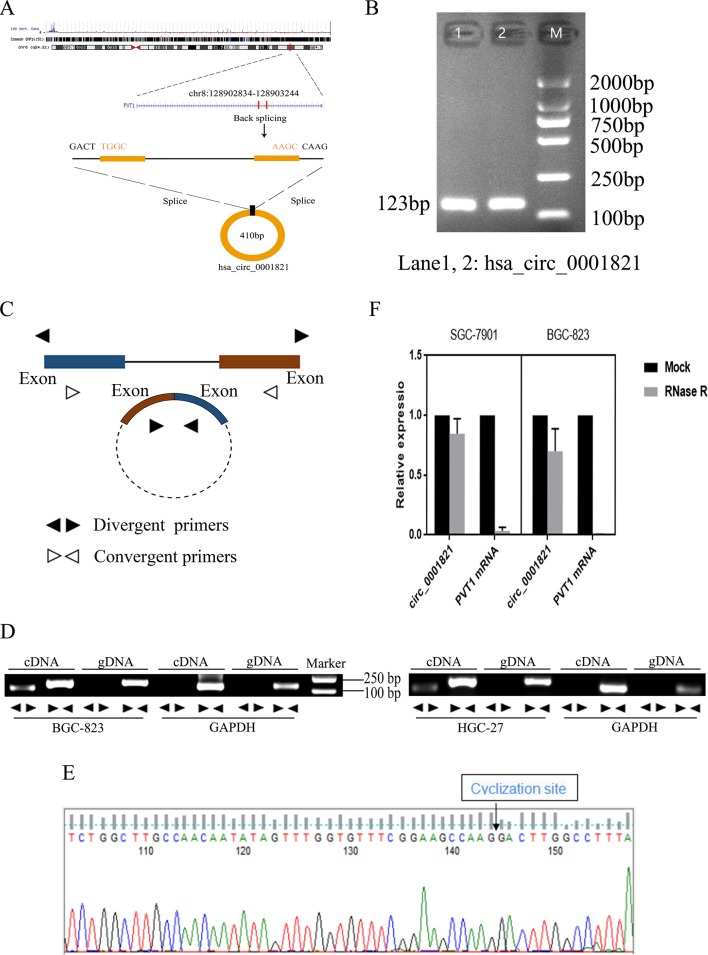
Methodological evaluation of hsa_circ_0001821 in gastric cancer (GC) cells. (A) The origin of hsa_circ_0001821 searched through the University of California Santa Cruz (UCSC) genome browser. (B) Verification of the size of the primer amplification product (123 bp) by agarose gel electrophoresis. (C) A schematic diagram for the design of polymerized primers and reverse primers. (D) Verification of the ring structure of hsa_circ_0001821. (E) Detection of the cyclization site by Sanger sequencing. (F) Hsa_circ_0001821 was tolerable to the degradation of RNA exonuclease in SGC-7901 and BGC-823 cells.